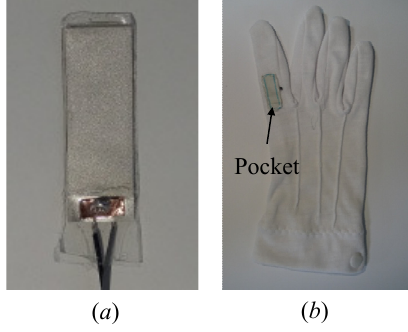
Figure 2. Pictures of ( a ) the piezoelectric composite and ( b ) the glove with the